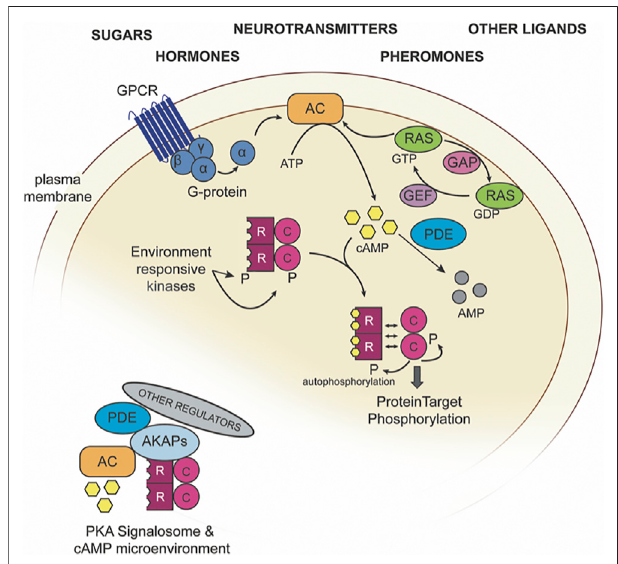
FIGURE2| AnoverviewofthePKAregulatorynetwork.PKAcatalytic(C) and regulatory (R) subunits can be regulated via cAMP abundance, which is controlled by adenylate cyclase (AC) and cAMP-dependent phosphodiesterases (PDEs). Inset, an example PKA